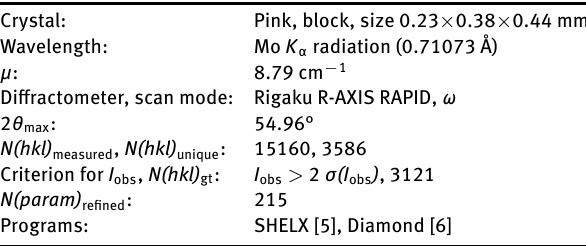
Table 1: Data collection and handling. Crystal: